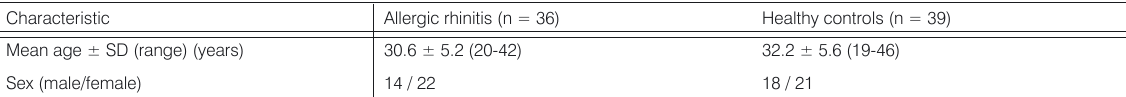
Table 1. Characteristics of patients and healthy